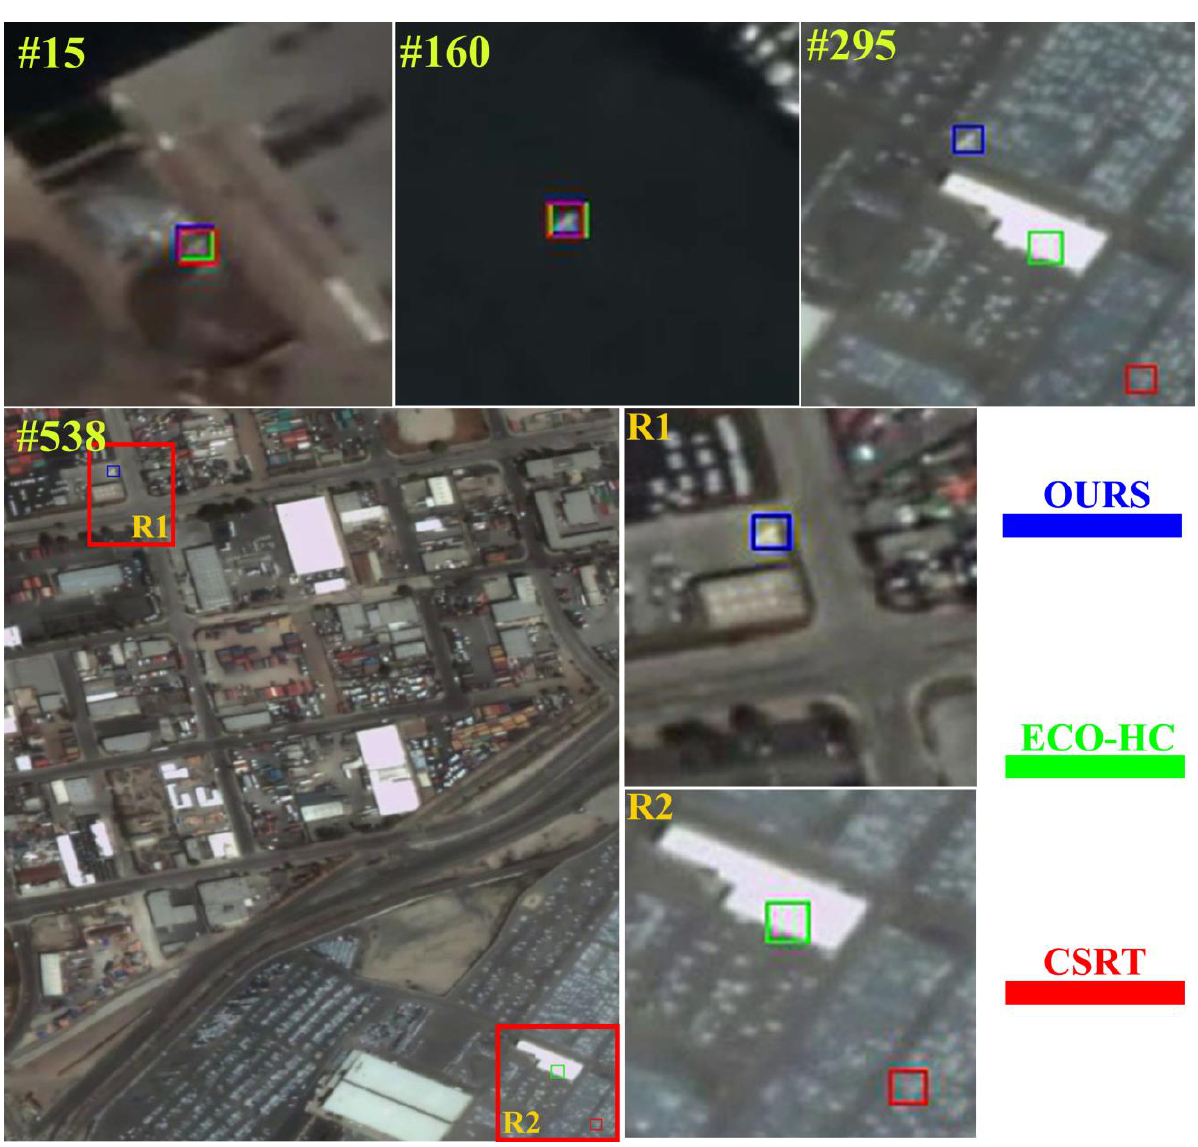
Figure 4 Example tracking results of different methods on the USA sequence. The number in the top left corner shows the frame number in the video. Our tracker is the only tracker tracking the target correctly from the beginning to the end. We draw the tracking results of some frames belonging to the experiment data sets in Figure 4. ECO-HC and CSRT are selected besides ours method as they get better performance comparing to STAPLE, LCT and KCF. In the USA sequence, ours can track the target accurately until the end of the video. We can see the ECO-HC tracking box staying in the similar background region obviously at the 295 frame, in addition CSRT has lost the target before